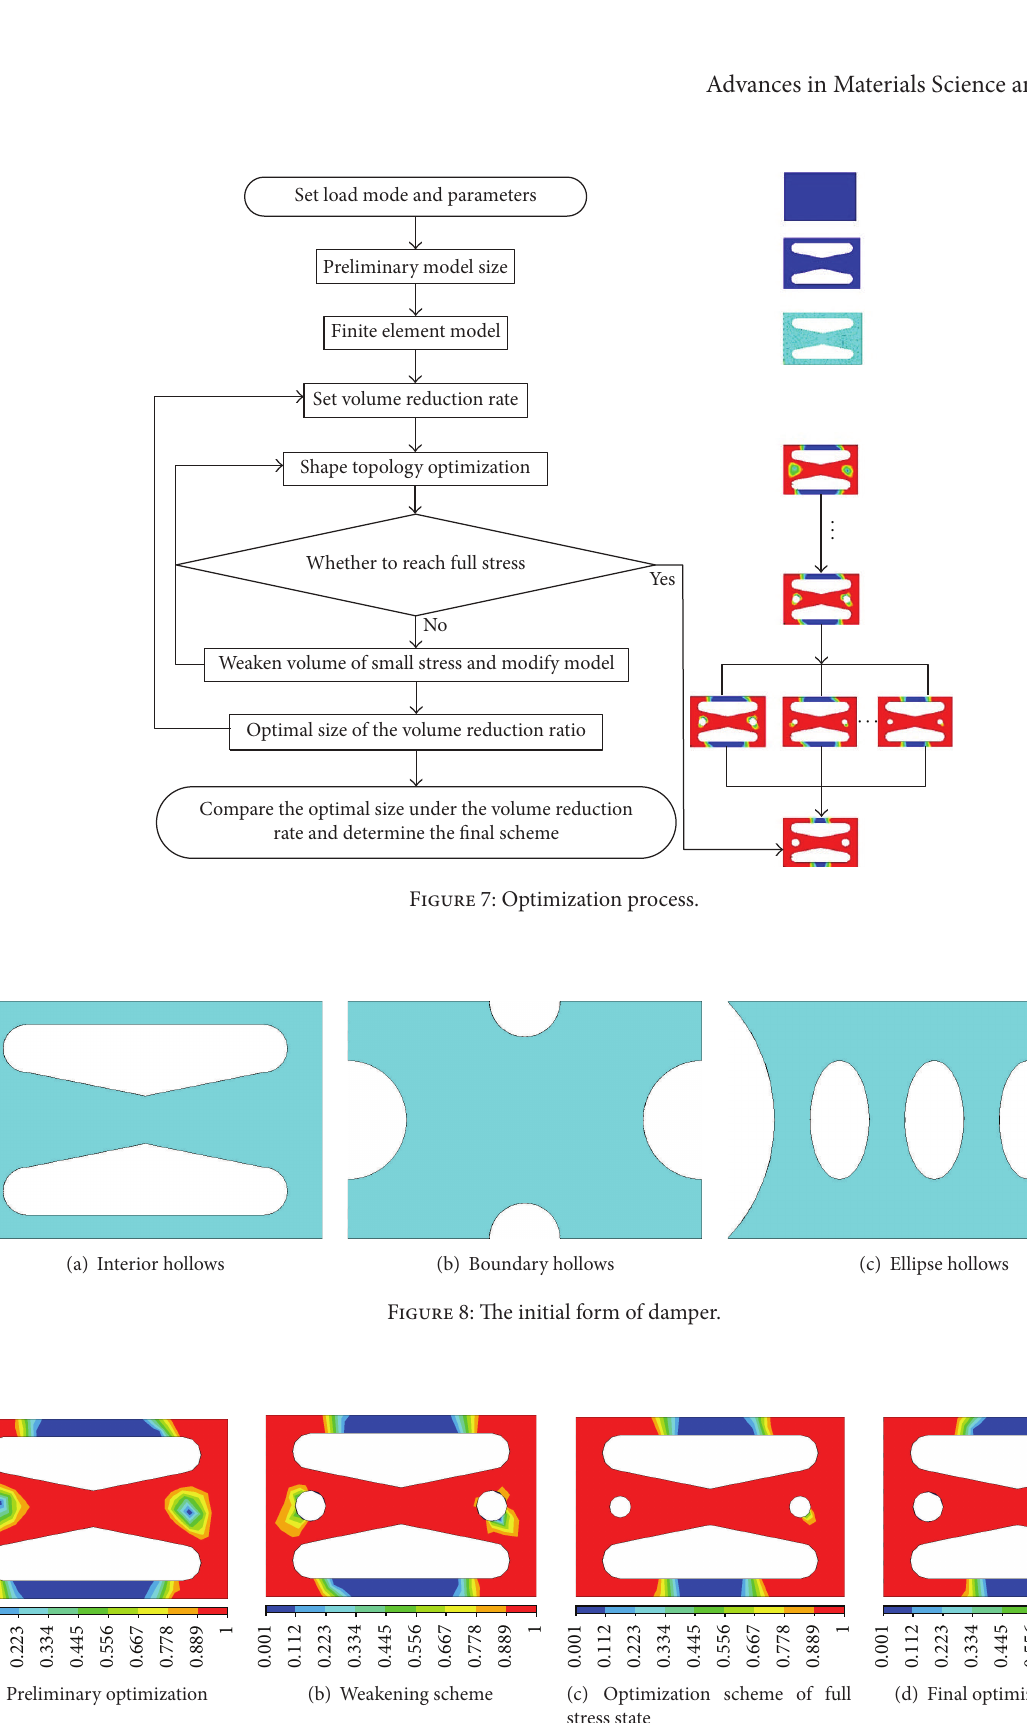
Figure 9: Optimization process of interior optimized